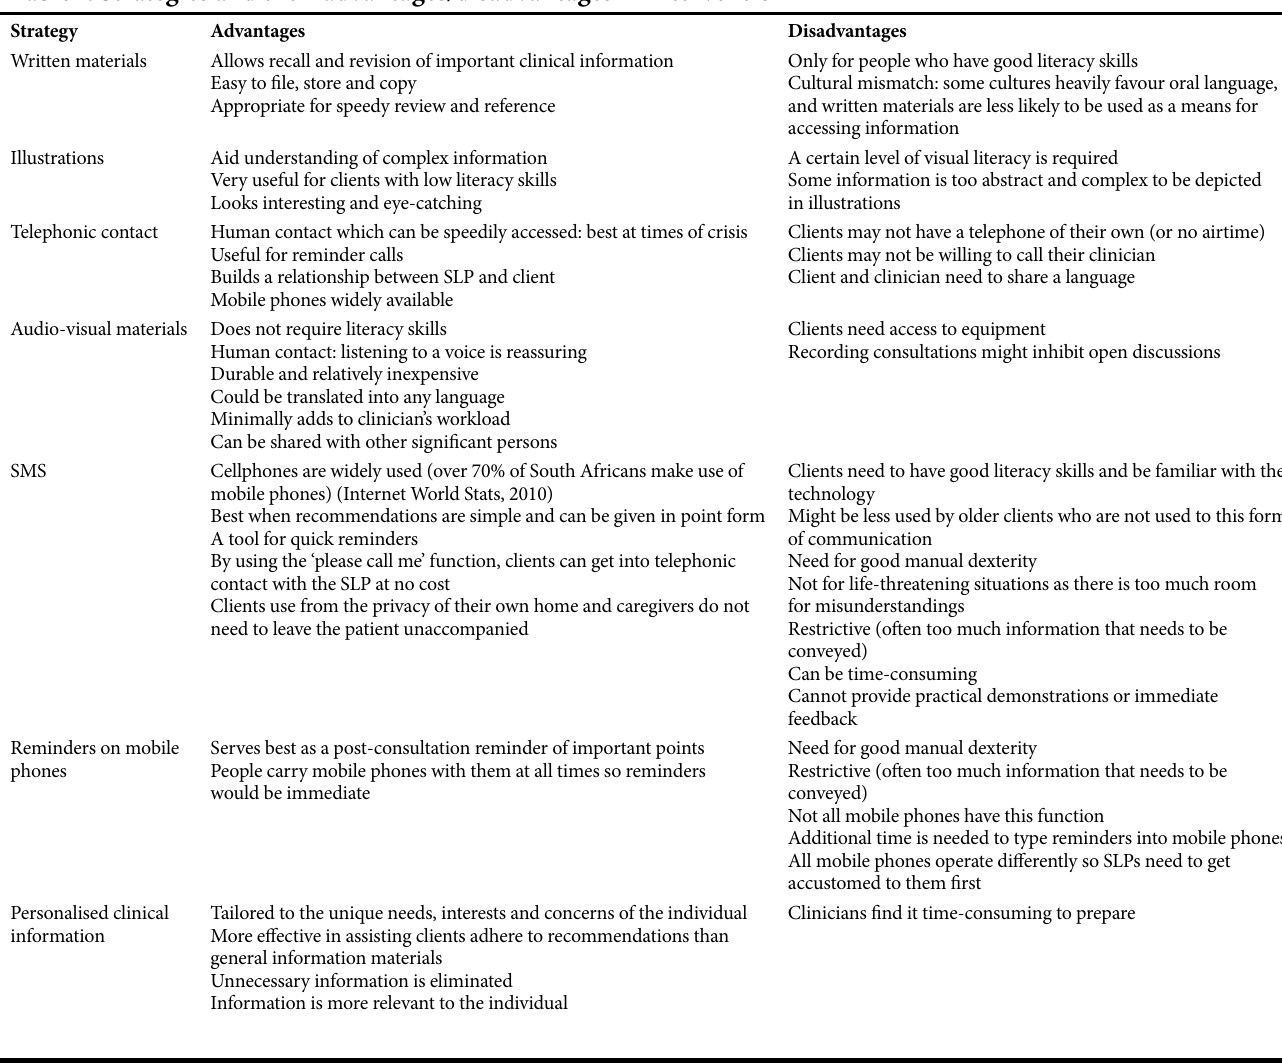
Table I. Strategies and their advantages/disadvantages in